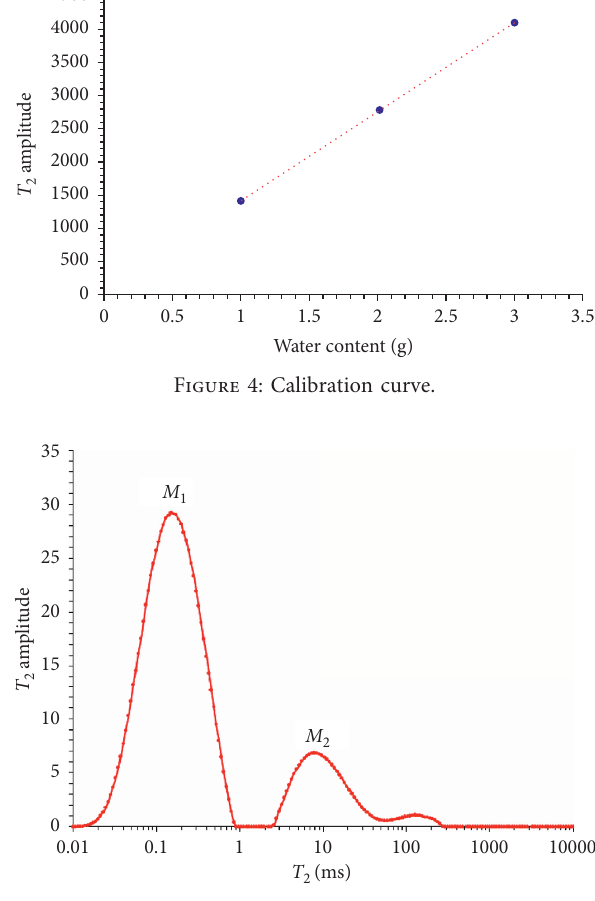
Figure 5: T 2 spectra of saturated coal